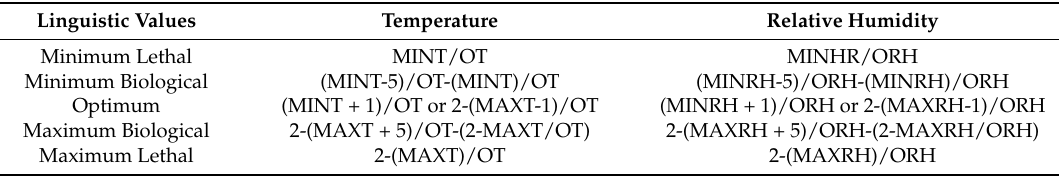
Table 2. Membership generic